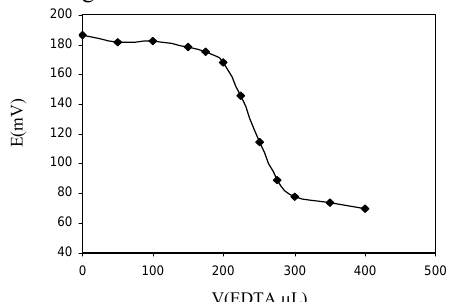
Figure 5. Potential titration curve of 25.0 mL from a 1.0 × 10 -4 mol L -1 Ho 3+ solution with 1.0 × 10 -2 mol L -1 of EDTA.